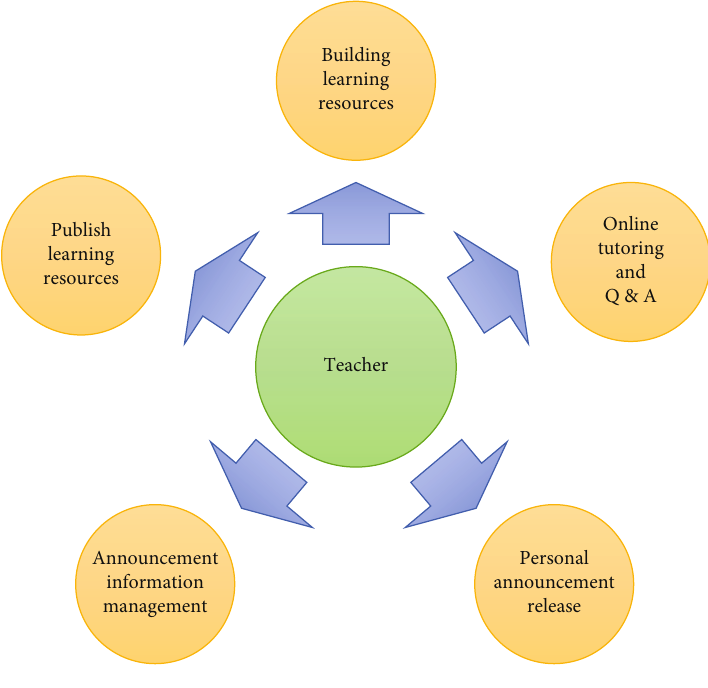
Figure 9: Teacher function diagram.